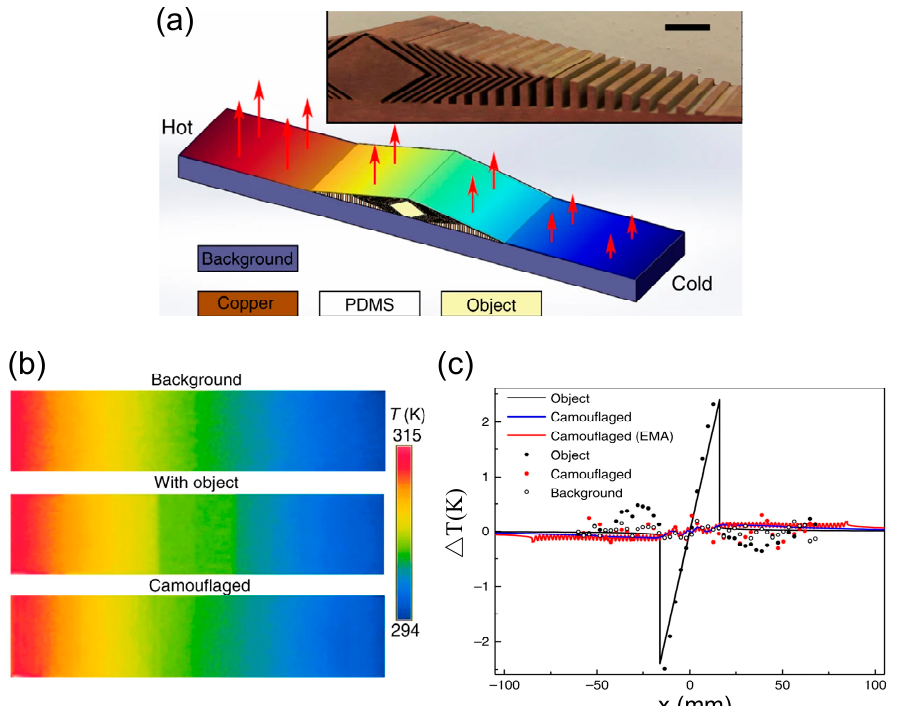
Figure 11. Radiative thermal cloak [17]. ( a ) Photograph of the fabricated sample; ( b ) measured ther- mal profiles of pure background, with base object, and with radiative thermal cloak; ( c ) quantitative comparison of surface temperature deviation.